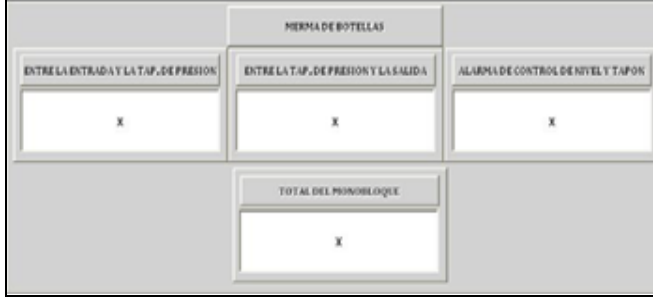
Figura 5: Conteo de mermas en el monobloque. Fuente: Los Autores, (2018).